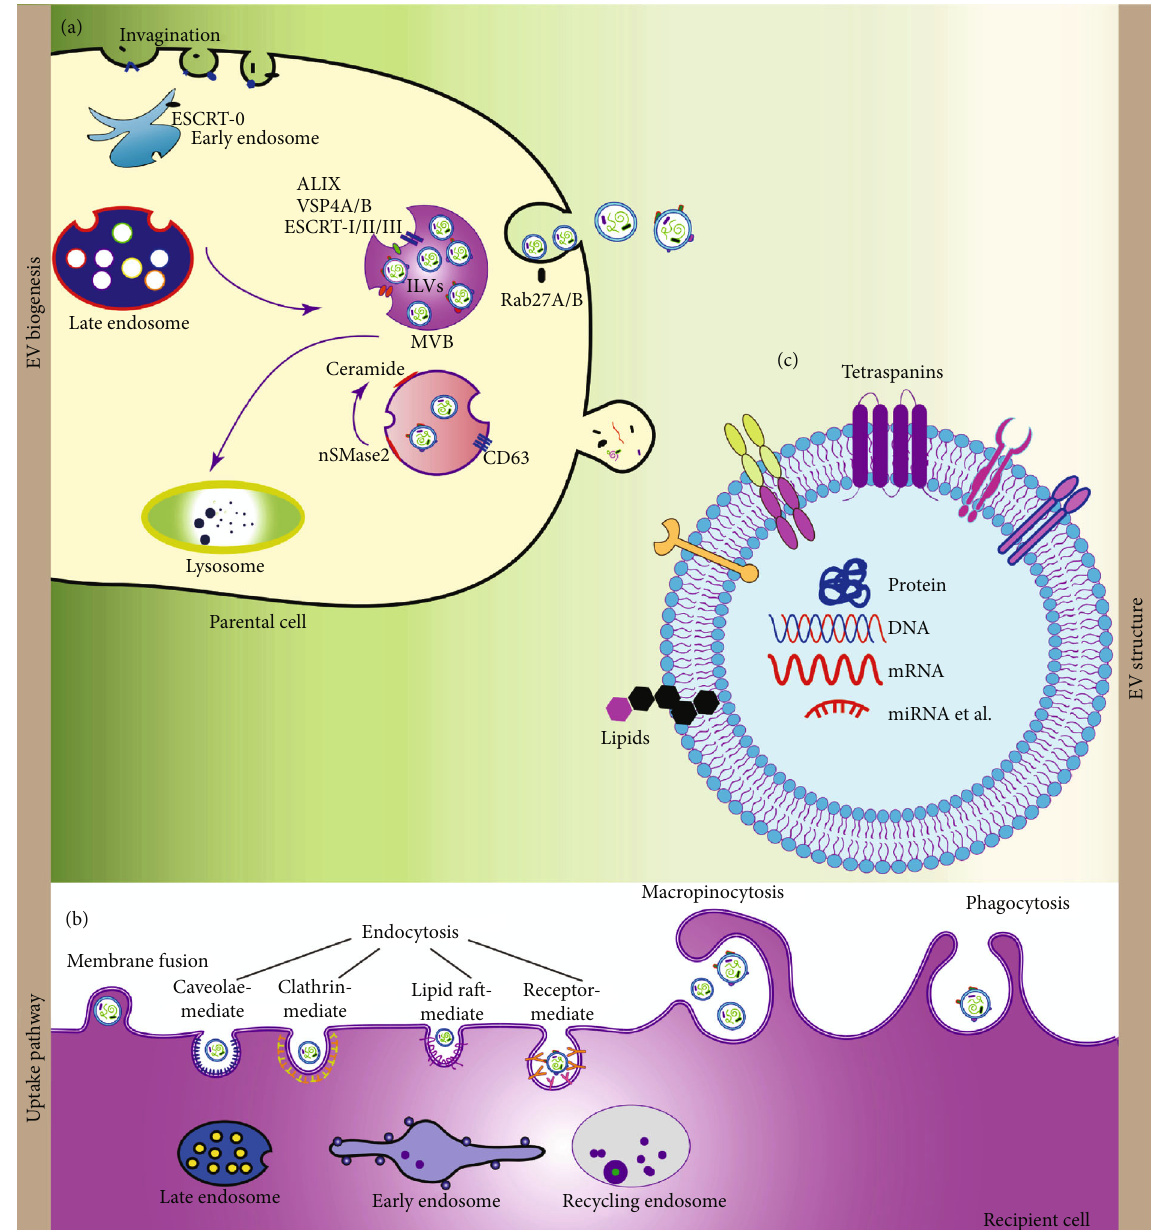
Figure 1: Biogenesis, composition, and uptake pathway of exosomes. (a) Exosomes were derived from the endosomal pathway. Extracellular biomaterial enters the cytoplasm through endocytosis pathway, then fuses with early endosome and develops into late endosome. Then, forms intraluminal vesicles (ILVs) containing vesicle structure in MVBs. When MVB fuses with lysosomes, it degrades the contents. When MVBs were transferred to plasma membrane resulting in the release of exosomes into the extracellular space. Endosomal sorting complex (ESCRT)-independent and dependent pathways required for exosome transport are involved in various stages of exosome formation. (b) Exosome components include proteins, lipids, nucleic acids, and small molecules, as well as surface proteins. (c) Exosomes can exert their e ff ects by binding to receptors present on the surface of target cells, or through endocytosis, membrane fusion,